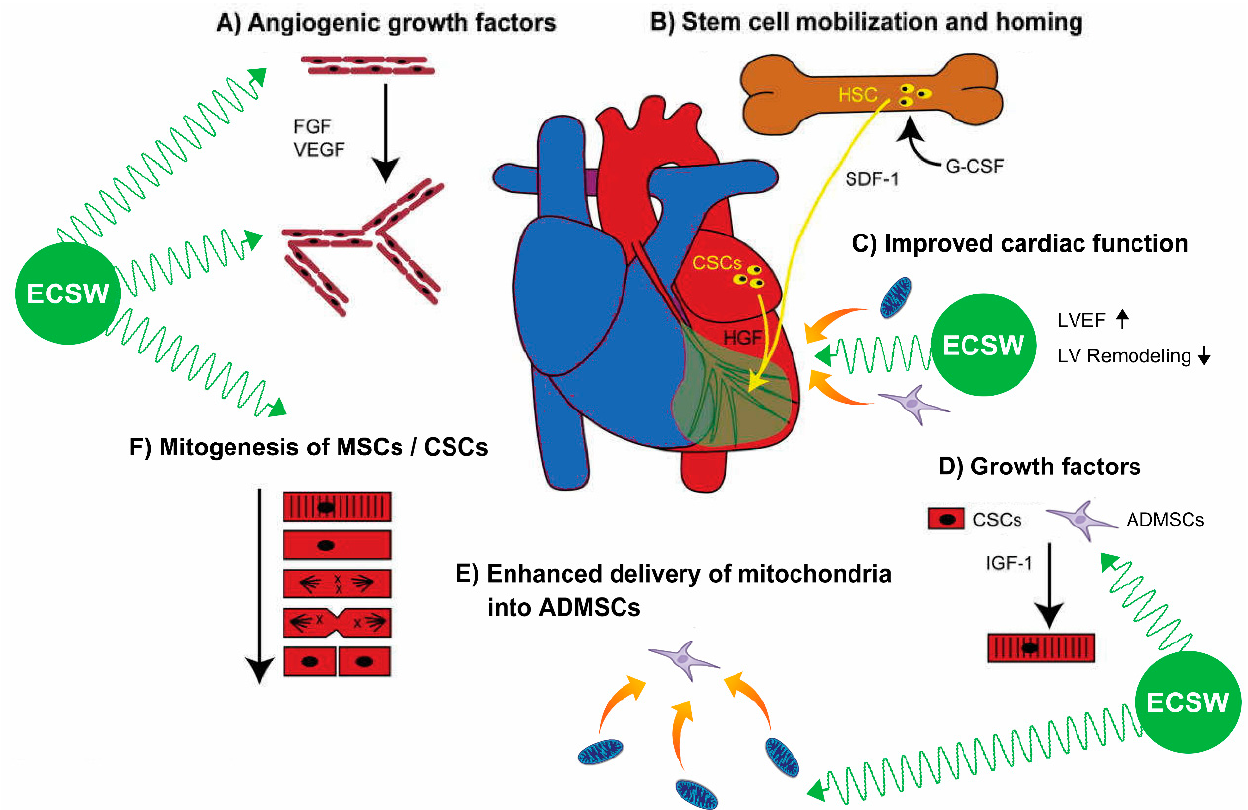
Figure 11. Summary demonstrating that ECSW-facilitated exogenous mitochondria into ADMSCs therapy ameliorated the LV function mainly through enhancing angiogenesis, expression of cardiac stem cells/growth factors in LV myocardium, mobilization of bone marrow-derived endothelial progenitor cells into circulation, MSC differentiation and soluble angiogenesis factors. ADMSCs = adipose-derived mesenchymal stem cells; ECSW = extracorporeal shock wave; DCM = dilated cardiomyopathy; LVEF = left ventricular ejection fraction; CSC = cardiac stem cell; VEGF = vascular endothelial growth factor; TGF-ß = transforming growth factor beta.